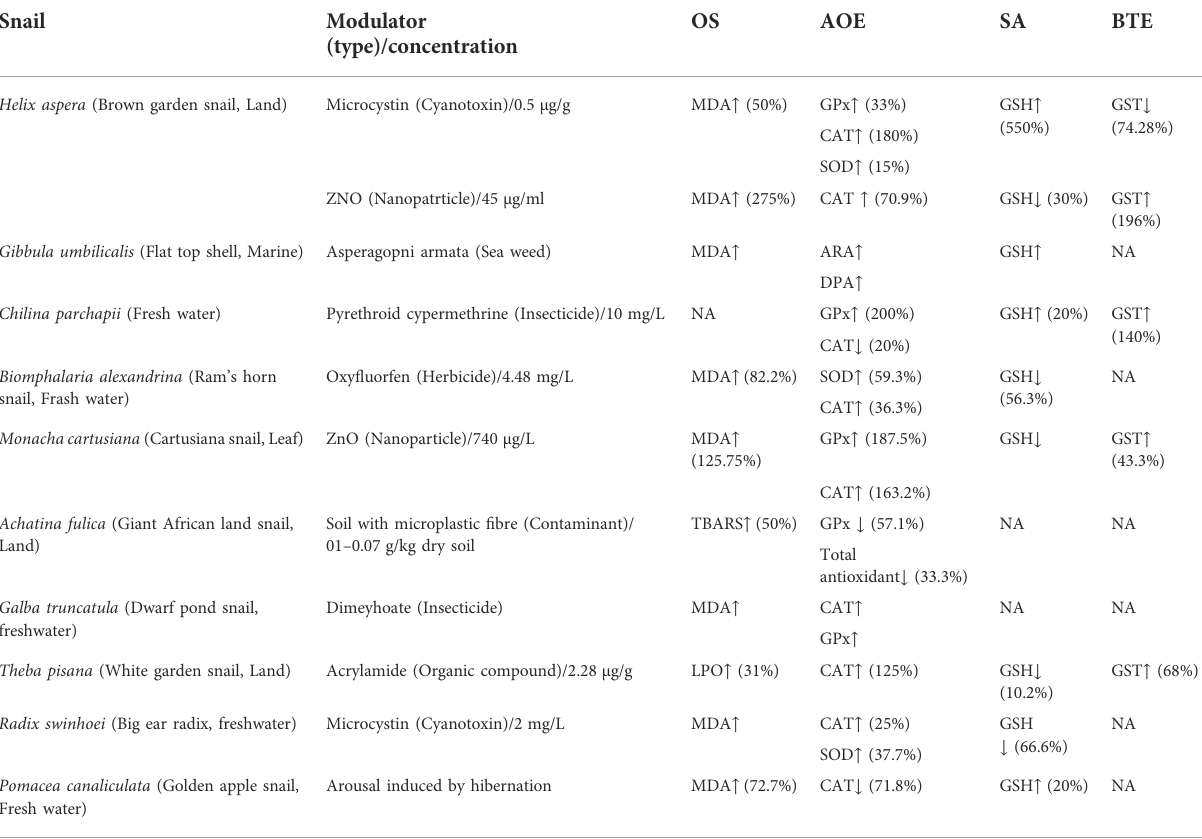
TABLE 4 Modulator induced oxidative stress of different snails. NA- Not analyzed. OS- oxidative stress.